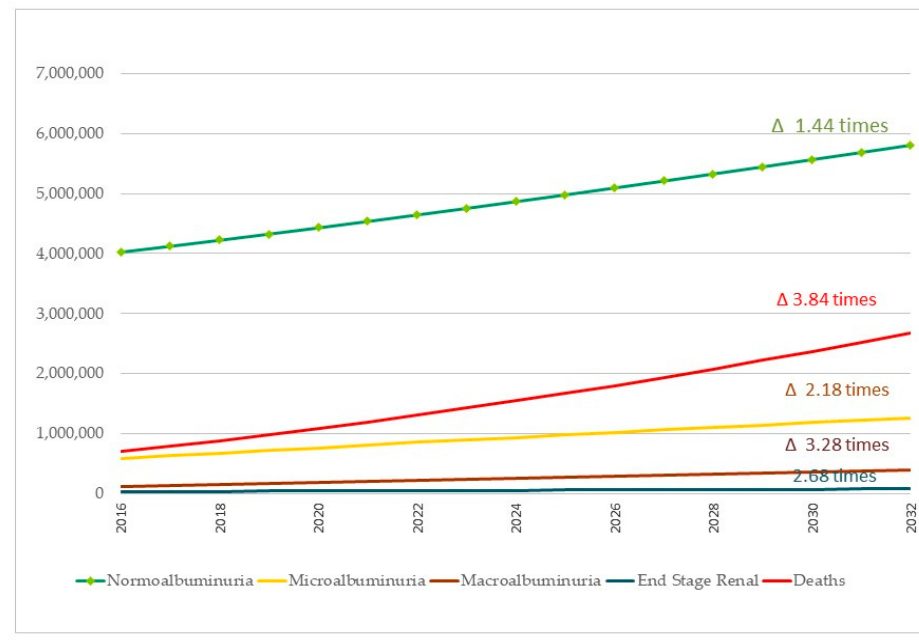
Figure 3. Health needs of CKD secondary to T2 DM in the Mexican population without social